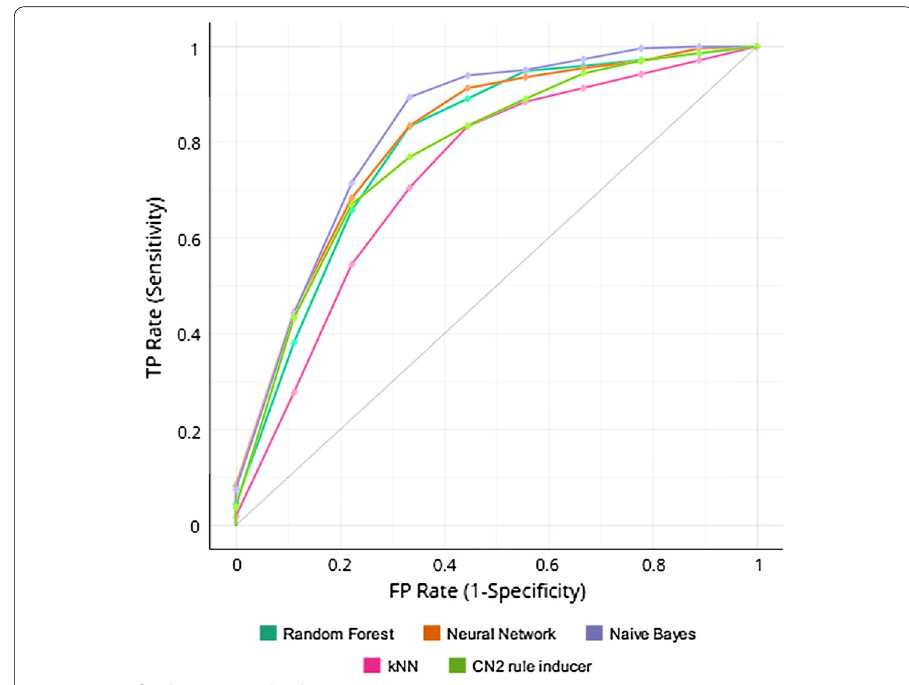
Fig. 16 ROC for the SDT IP upload TSC